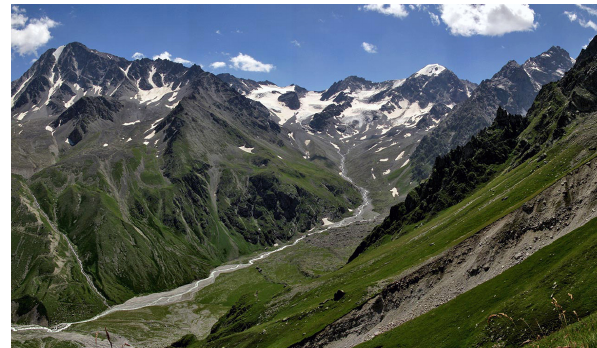
Figure 4. Typical terrain in the Mamison